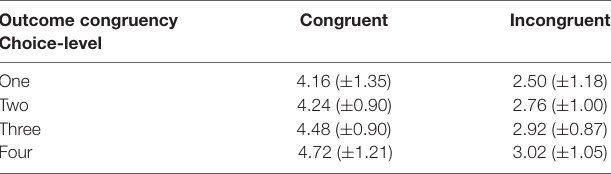
TABLE 2 | Means and standard deviations of FoC ratings in each choice-level and outcome-congruency condition. Outcome congruency